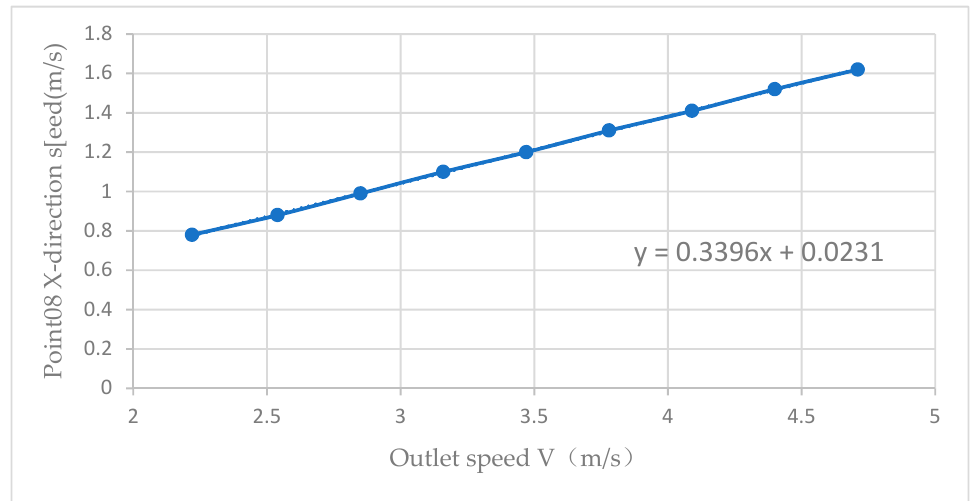
Figure 5. P08 point x -direction speed scatter diagram and fitting curve.